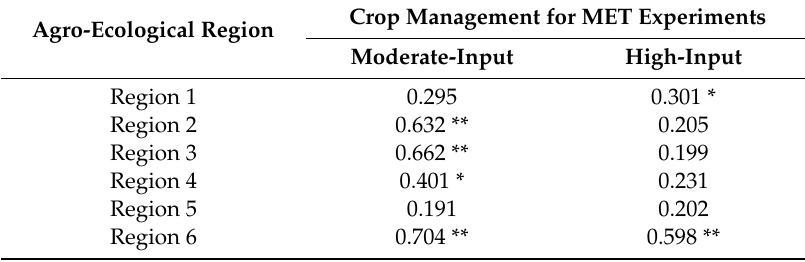
Table 2. Correlation coefficients ( r s ) for cultivar yield ranking between the survey dataset and the multi-environmental trial (MET) dataset.